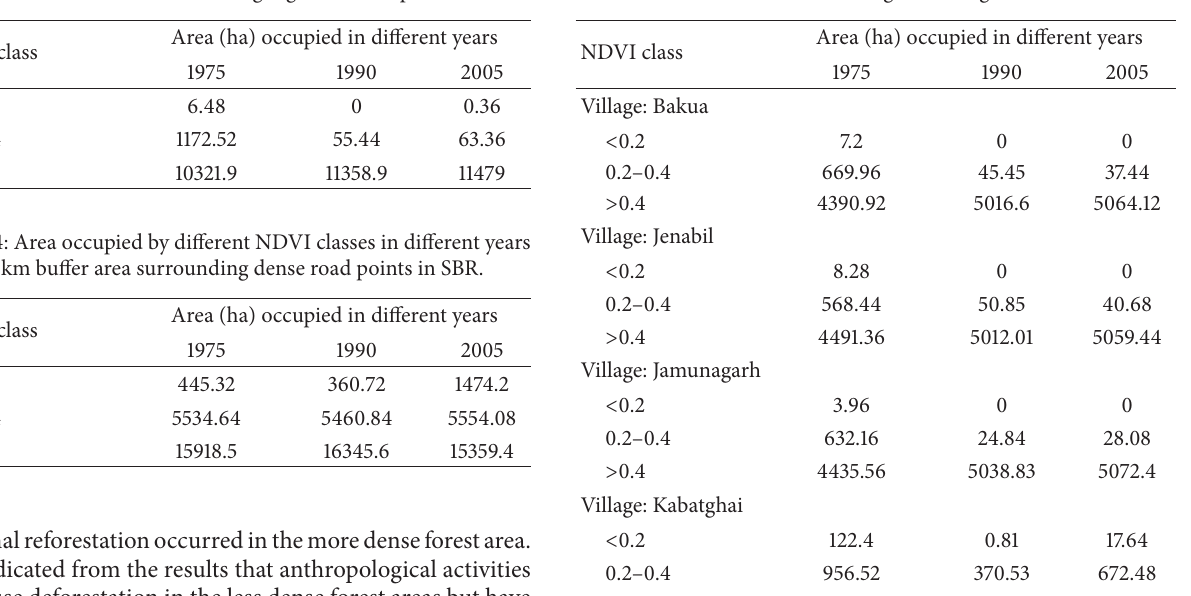
Table 3: Area occupied by different NDVI classes in different years in the 4km buffer zones surrounding high elevation points in SBR.